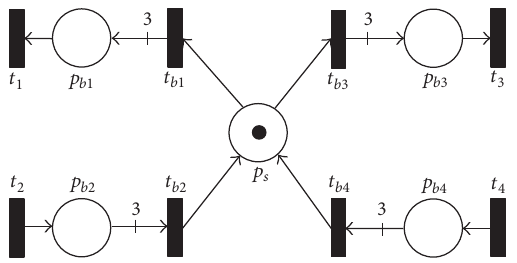
Figure 5: The periodic mutual exclusion supervisor of the two MESRs depicted in Figures 2(b) and